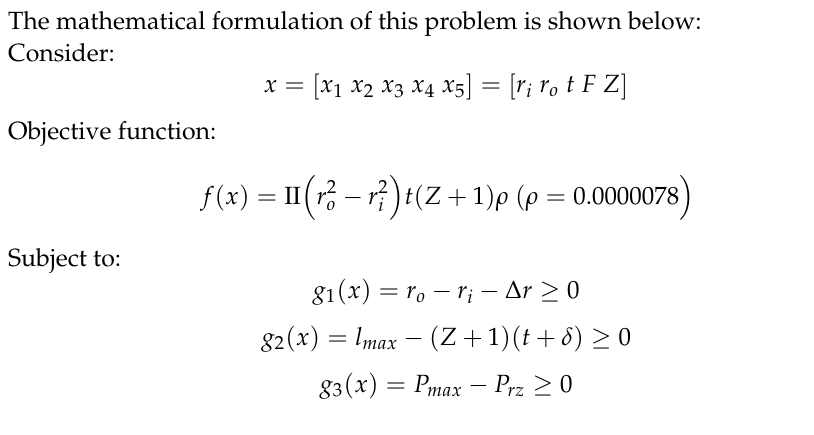
Figure 13. Model of the multiple disc clutch brake.